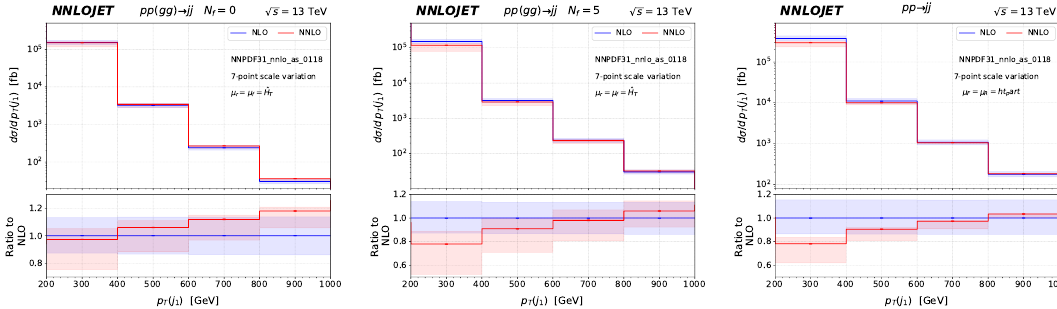
Figure 13 . p T ( j 1 ) distribution for pp ( gg ) → jj with N f = 0 (left), pp ( gg ) → jj with N f = 5 (centre) and pp → jj